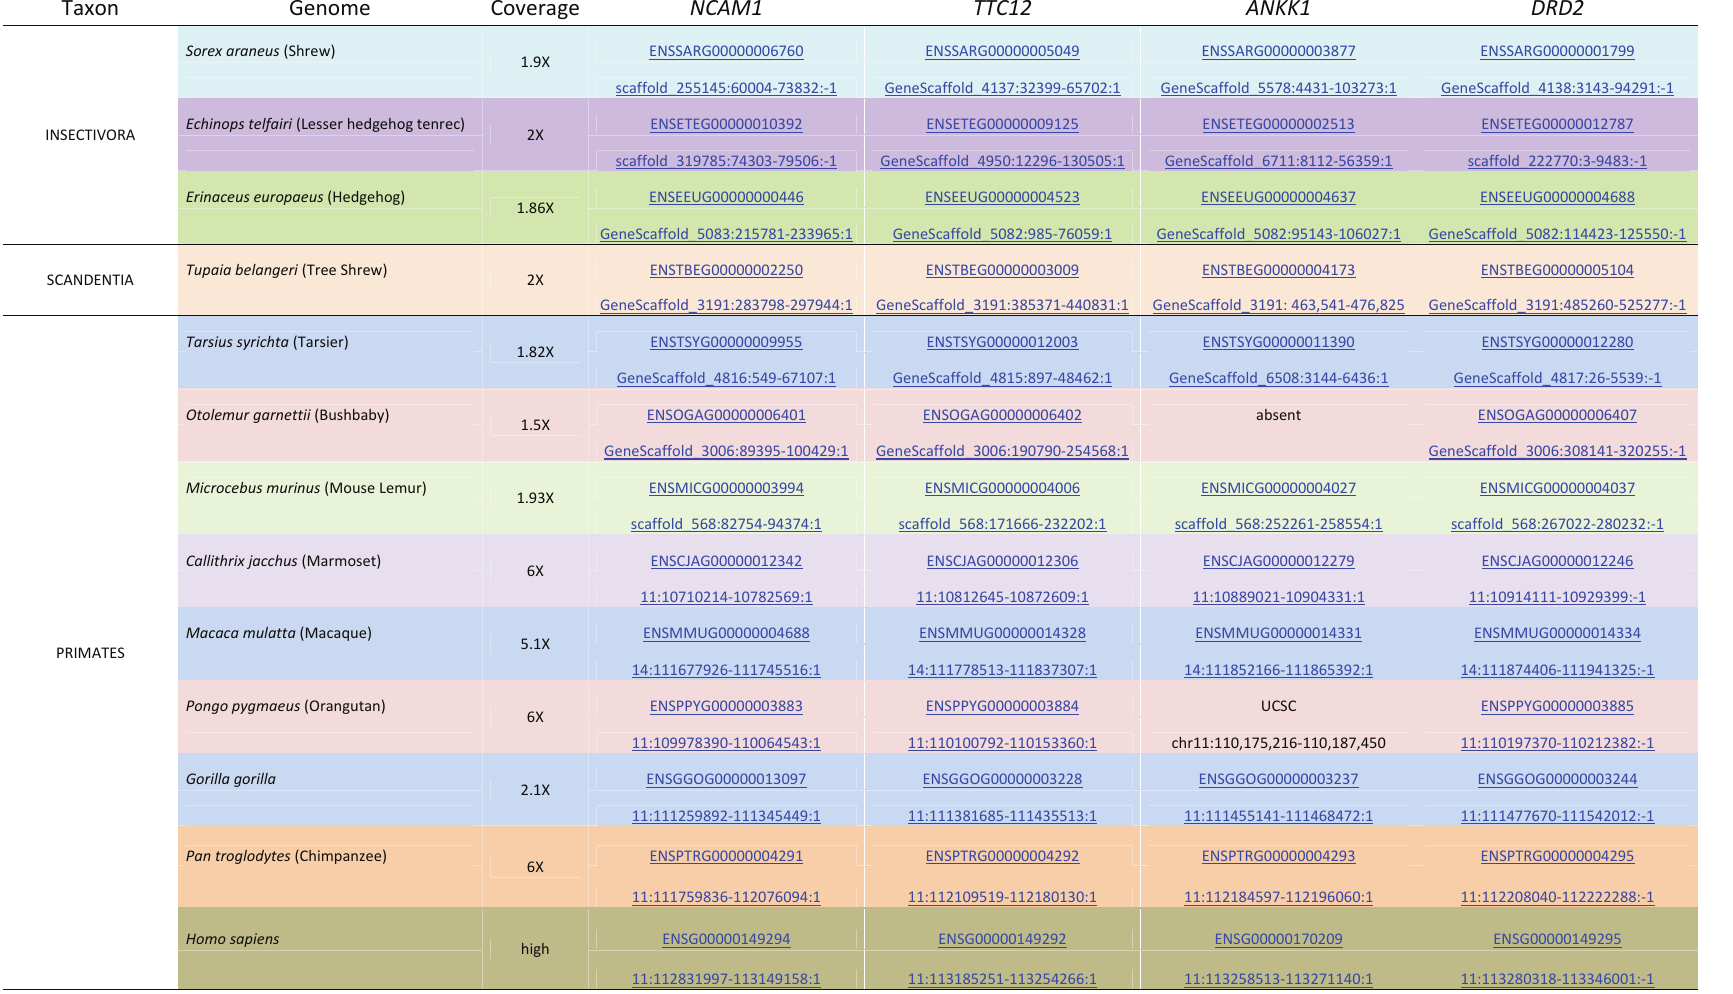
Table S1 (cont). Orthologues of genes in the NTAD cluster in 47 available vertebrate genomes, showing accession number and location.